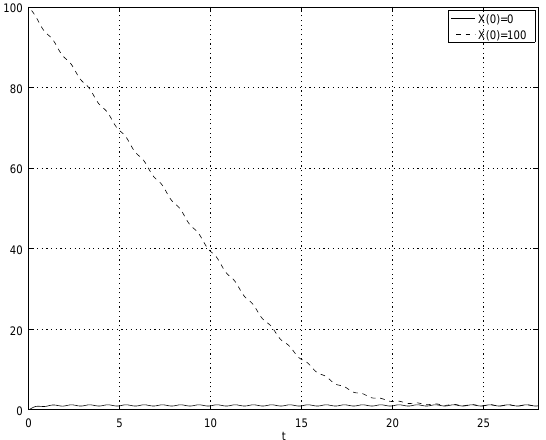
Figure 1. The mean E ( t ,0 ) and E ( t ,100 ) for t ∈ [ 0,28 ] , this figure shows the rate of